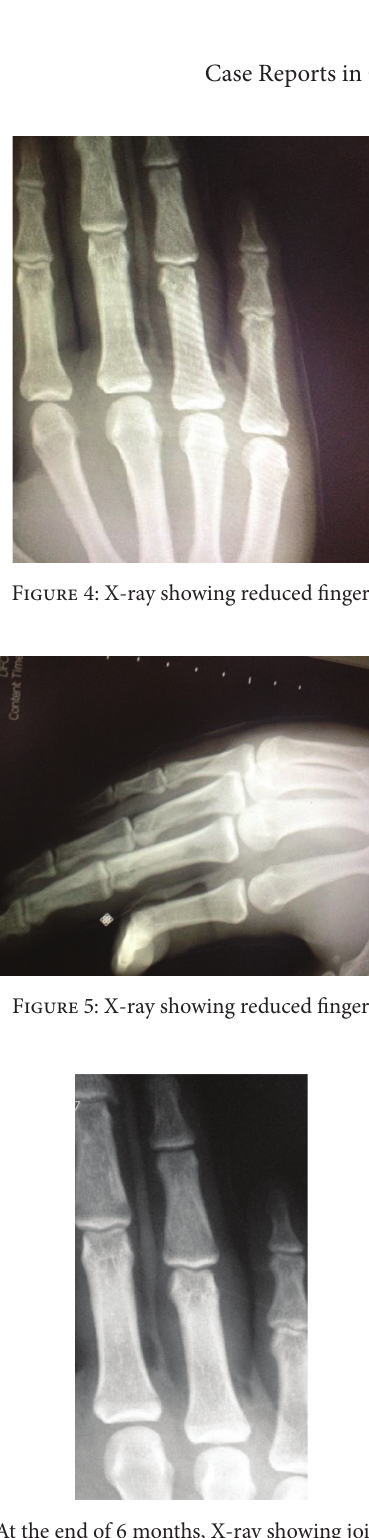
Figure 6: At the end of 6 months, X-ray showing joint